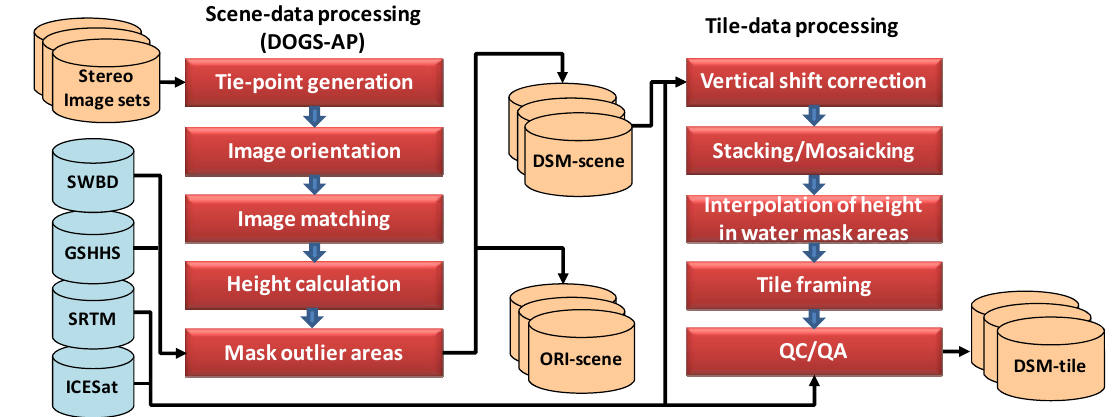
Figure 1. Processing flow of the ‘AW3D’ global DSM